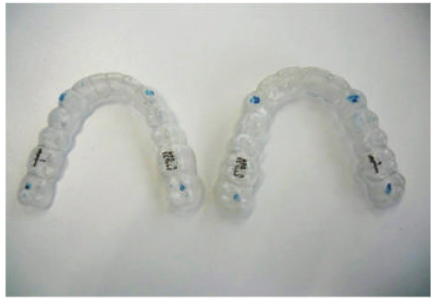
Figure 6: Clear orthodontic aligners.